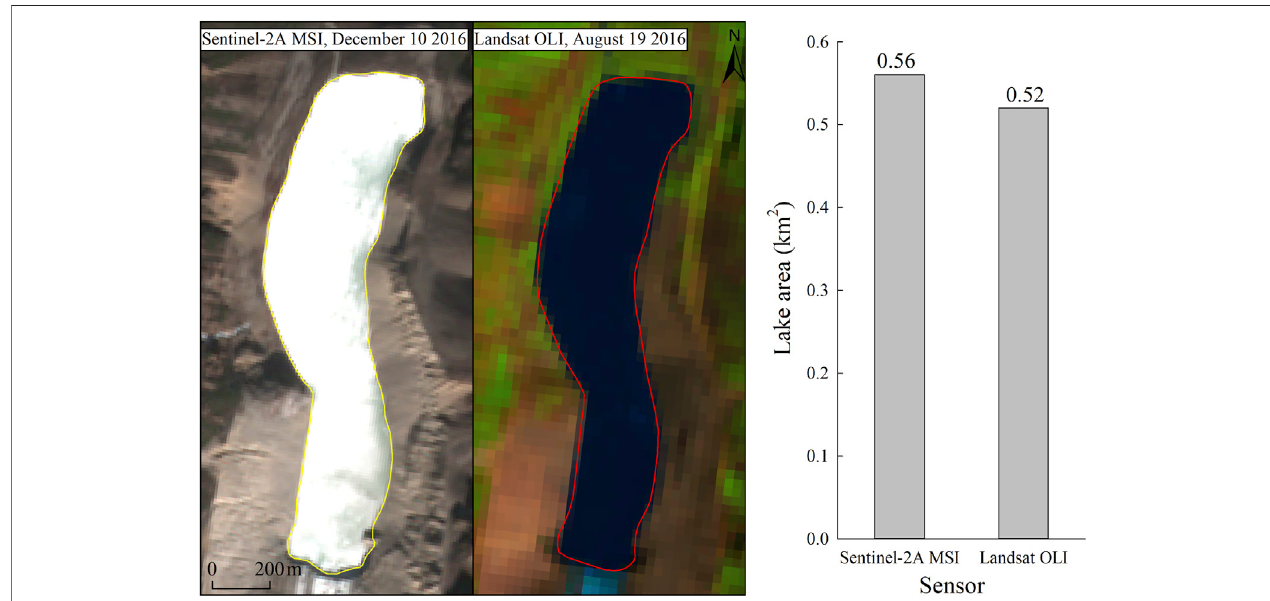
FIGURE 4 | The comparison between lake outline obtained by our method and that obtained by visual interpretation reference to Sentinel-2A MSI image.